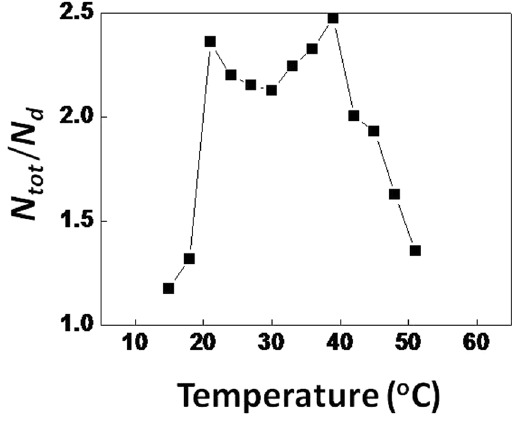
Figure 3. The N tot / N d ratio at different temperatures. This ratio is dimensionless and describes nitrogenase activity in the heterocyst. The ratio indicates the contribution of photosynthesis to nitrogenase activity. A ratio of 2 means that photosynthesis and respiration contribute equally to nitrogenase activity, while a ratio of 1 means that respiration alone satisfies nitrogenase activity.